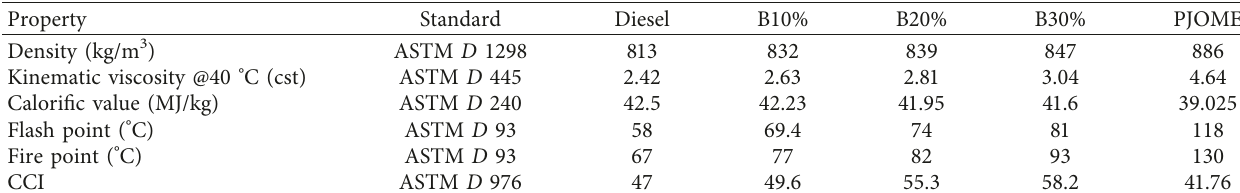
Figure 2: Picture of (a) soxhlet reactor apparatus and (b) transesterification setup. Table 1: Properties of test fuels.